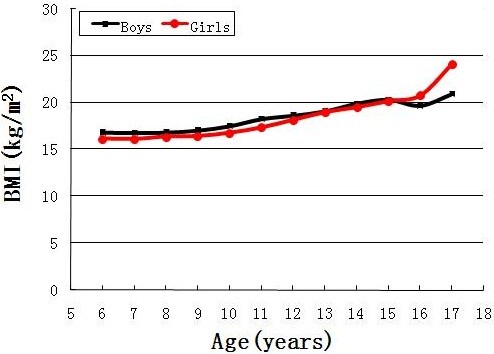
Median body mass index by age and gender. The 25th and 75th percentiles of BMI were 16.3 and 20.5 kg/m2, respectively.